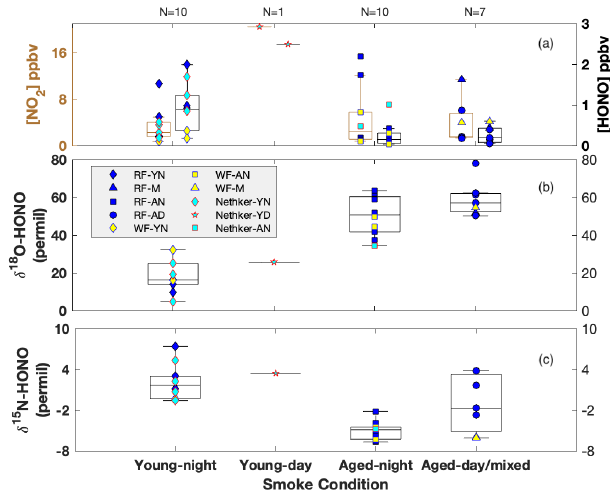
Figure 2. Box-whisker plots for concentration of NO 2 (left) and HONO (right) (a) , δ 18 O-HONO (b) and δ 15 N-HONO (c) for each sample. Individual data points are plotted within each box grouped by various field smoke conditions including young nighttime smoke (YN), young daytime smoke (YD), mixed daytime smoke (M) that contains smoke contributed by either night smoke or fresh smoke, aged nighttime smoke (AN) and aged daytime smoke (AD). Data from three wildfires are shown here, including Rabbit Foot (RF) fire during the 2018 WE-CAN campaign, Williams Flats (WF) fire and Nethker fire during the 2019 FIREX-AQ campaign. N is sample number measured for each condition. Each box-whisker presents the 5th, 25th, 50th, 75th and 95th percentile of sample values in each